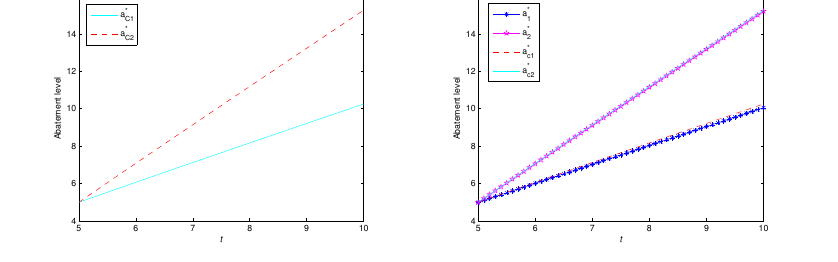
Figure 5. Comparison pollution stocks between cooperative and noncooperative transboundary pollution